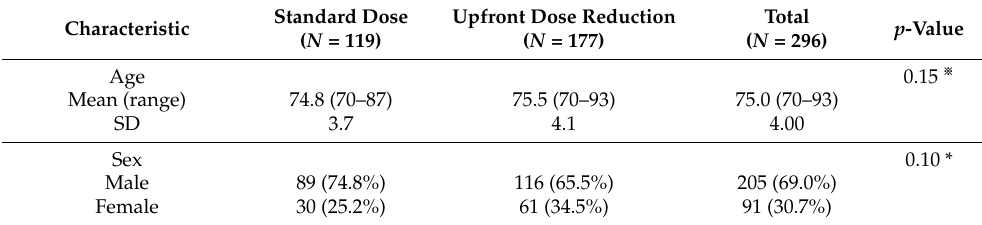
Table 1. Patient